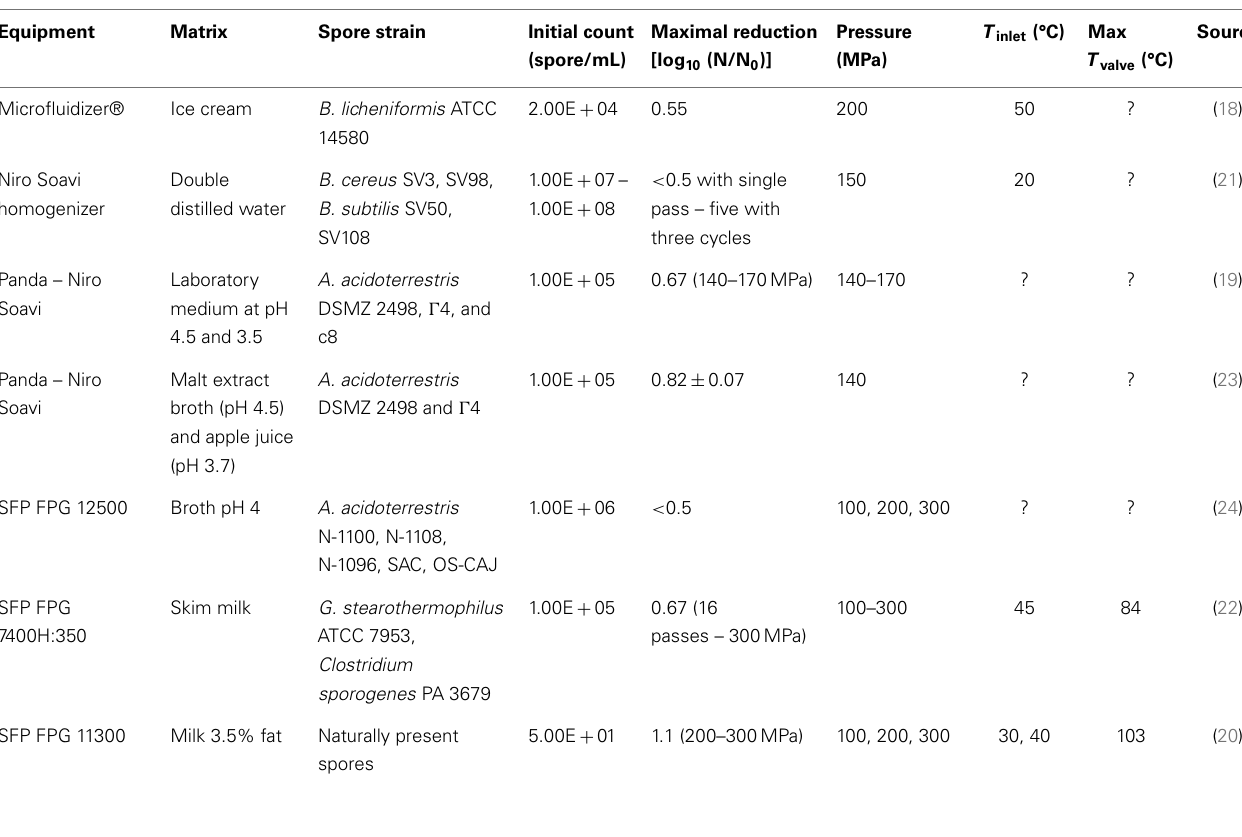
Table 1 | Overview of literature on non-successful HPH/UHPH inactivation of bacterial spores